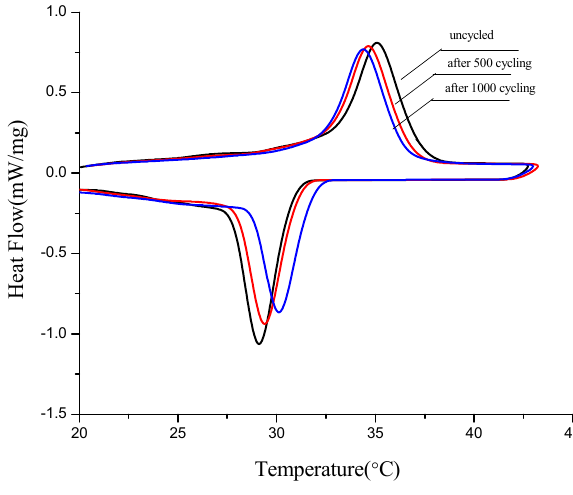
Figure 13. DSC curves of FS TD-MA PCM before cycling, after 500 and 1000 cycling.